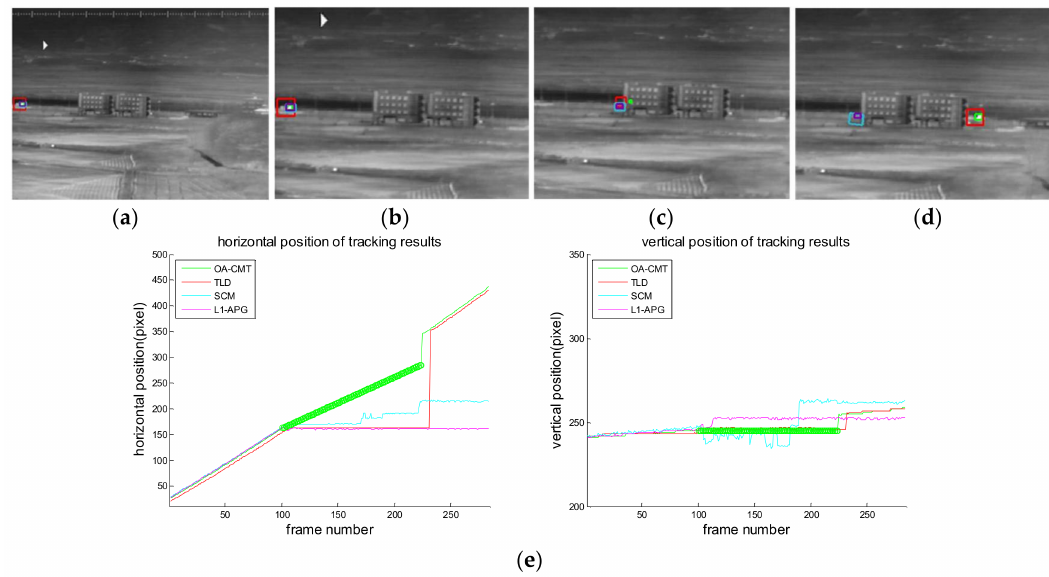
Figure 19. Computer simulation result of imagery ID 4. ( a ) Normal tracking status (original image); ( b ) magnifying interested area; ( c ) OA-CMT turns to memory tracking status as the car is hidden by a building ( d ) TLD and OA-CMT re-lock target successfully; ( e ) tracking trajectories of each tracker. Predicted position of target of OA-CMT has no big difference with the position of the target after blind time.